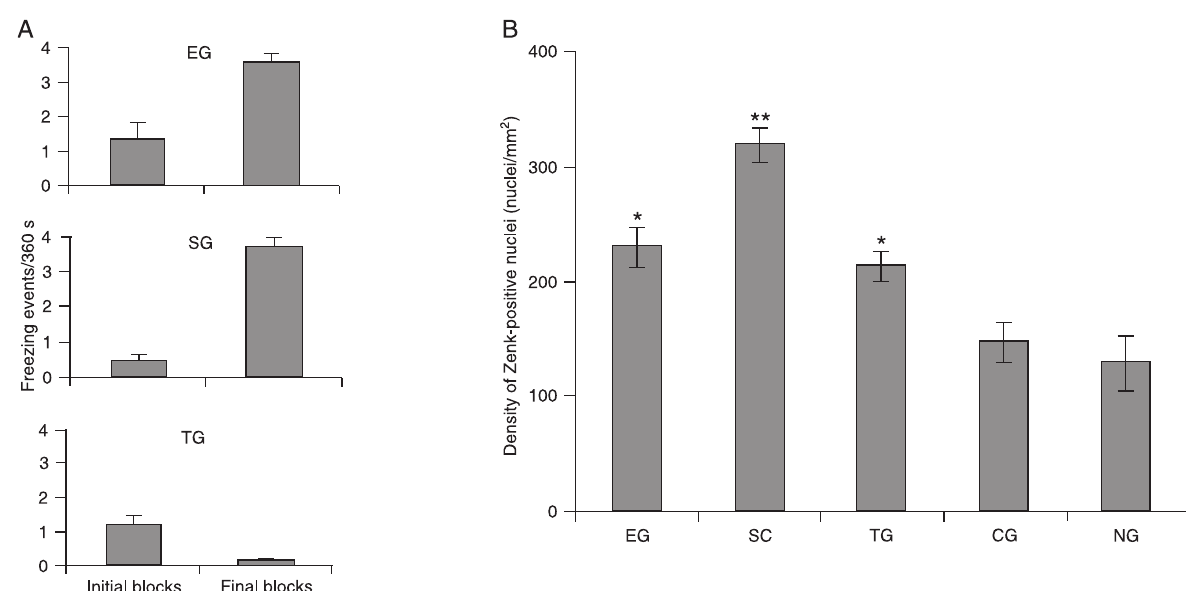
Figure 1. A , Freezing occurrences during the initial and final blocks of the training session for the experimental group (EG; N = 6), shock group (SG; N = 7) and tone group (TG; N = 7). B , Cell density of labeled nuclei in the nucleus taeniae of the amygdala of pigeons. Data are reported as means ± SEM. Context group (CG; N = 6); naive group (NG; N = 6). *P < 0.05 compared to CG and NG; **P < 0.05 compared to EG, TG, CG, and NG (one-way ANOVA followed by the Tukey-Kramer multiple-comparison